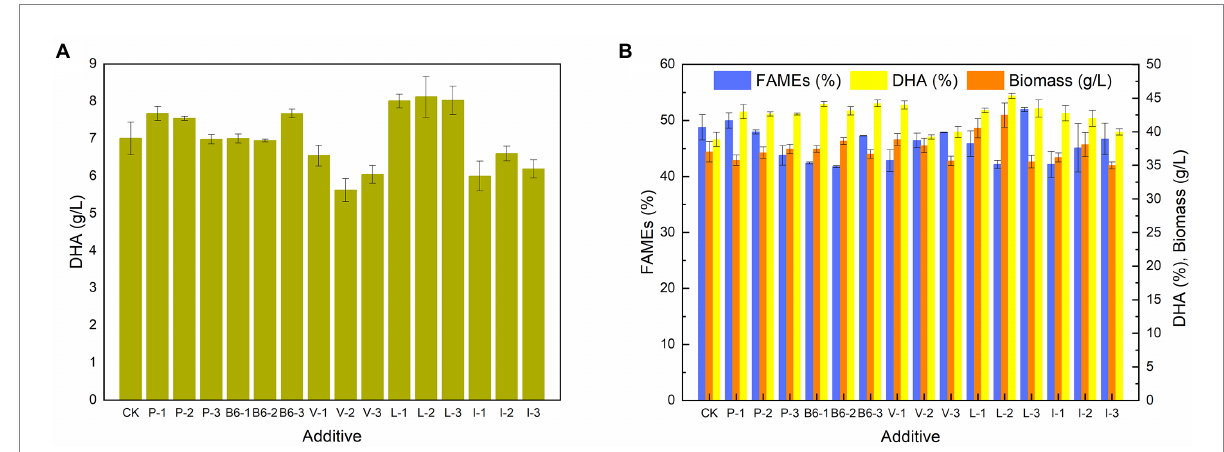
FIGURE 6 Effect of additives on growth, FAME, DHA content, and DHA yield of Schizochytrium sp. FJU-512 when shake culture at 72 h. Each point is the mean ± SD of three independent experimental replicates. Error bars represent standard errors of the means. CK: control group (no additive added); P-1, P-2, P-3: addition of 1, 2.5 and 4 mmol/l sodium pyruvate, respectively; B6-1, B6-2, B6-3: 0.05, 0.25, and 0.45 mg/ml of Vitamin B6, respectively; V-1, V-2, V-3: 0.06, 0.30, and 0.54 mg/ml of Val, respectively; L-1, L-2, L-3: 0.06, 0.30, and 0.54 mg/ml of Leu, respectively; I-1, I-2, I-3: 0.06, 0.30, and 0.54 mg/ml of Ile, respectively. (A) Concentration of DHA (g/L). (B) Concentration of biomass, FAME (%), and DHA